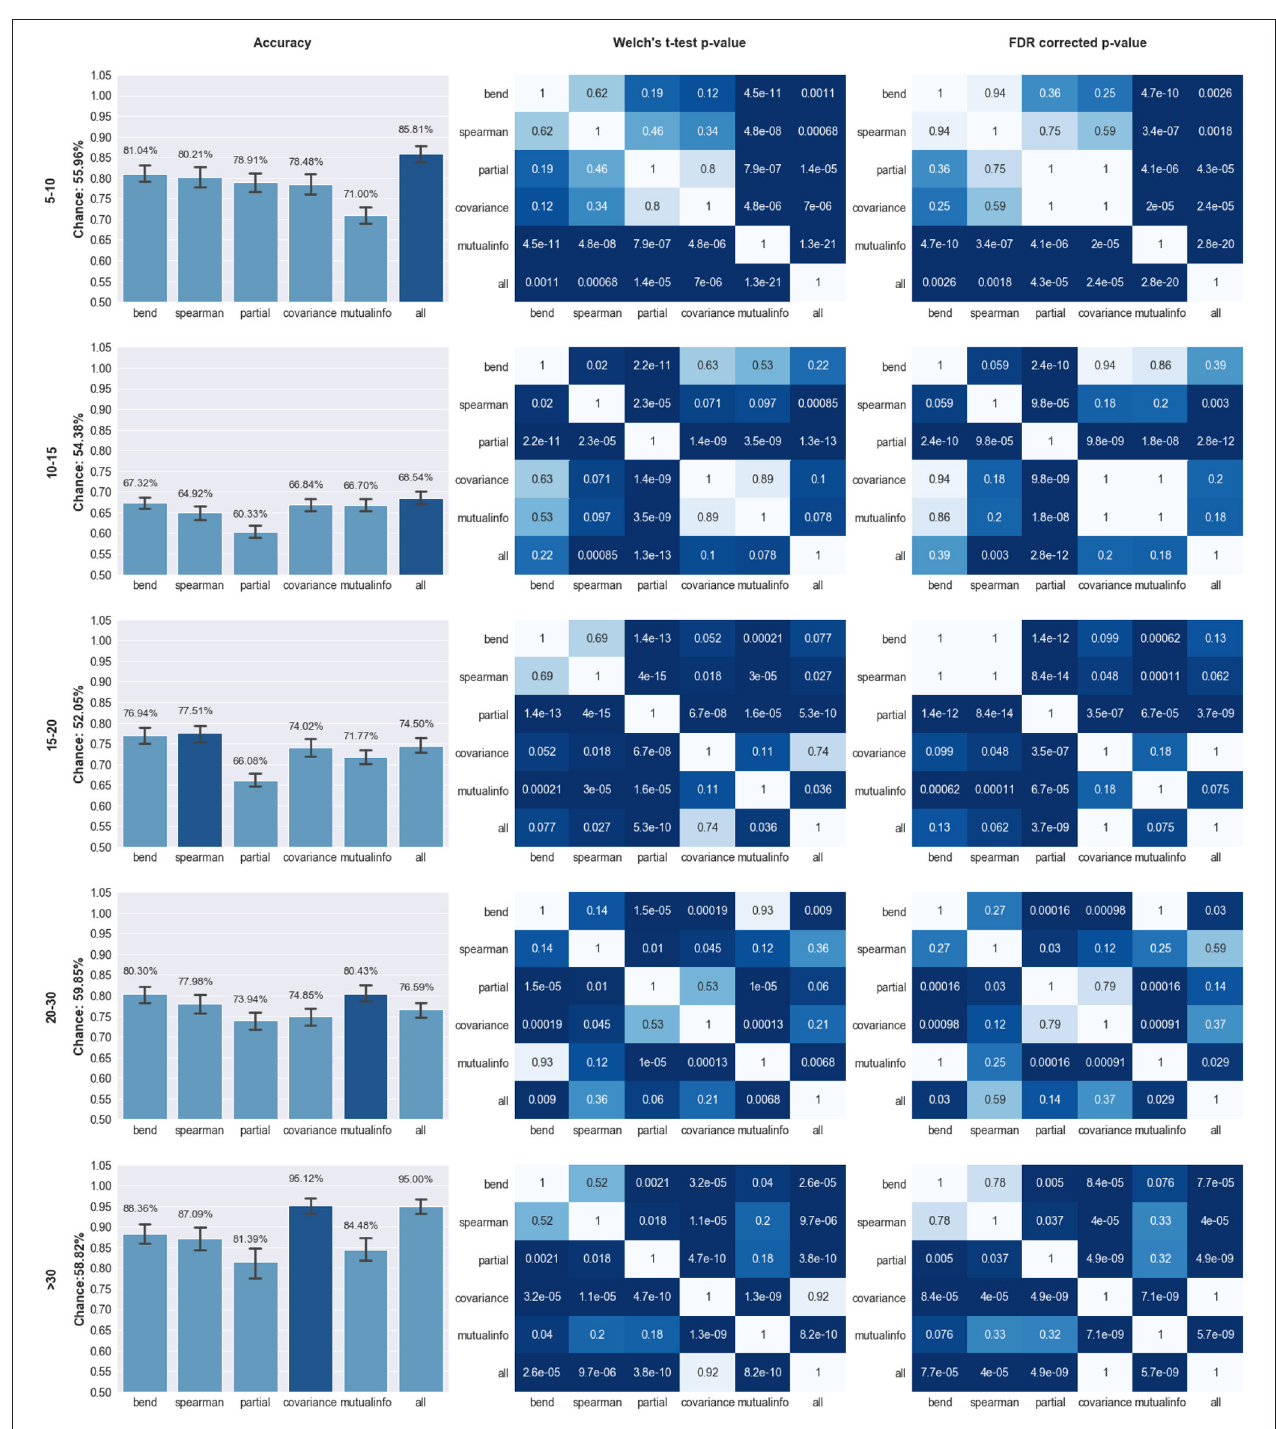
FIGURE 2 | Comparison of Model Performance; Left Column: Accuracy of the models trained using features extracted from the pipeline specified on the X axis for the age range specified on the far left (in years). Y axis labels specify the chance level for the classification task. Top preforming model is highlighted in dark blue; Middle Column: p -values of the Welch’s t -test preformed on the models trained on different pipelines. Statistical significance ( p < 0.05) is highlighted in dark blue; Right Panel: FDR corrected p -values based on the Benjamini, Hochberg method (Benjamini and Hochberg, 1995). The corrected p -values were capped at 1 therefore any value over that threshold was set to